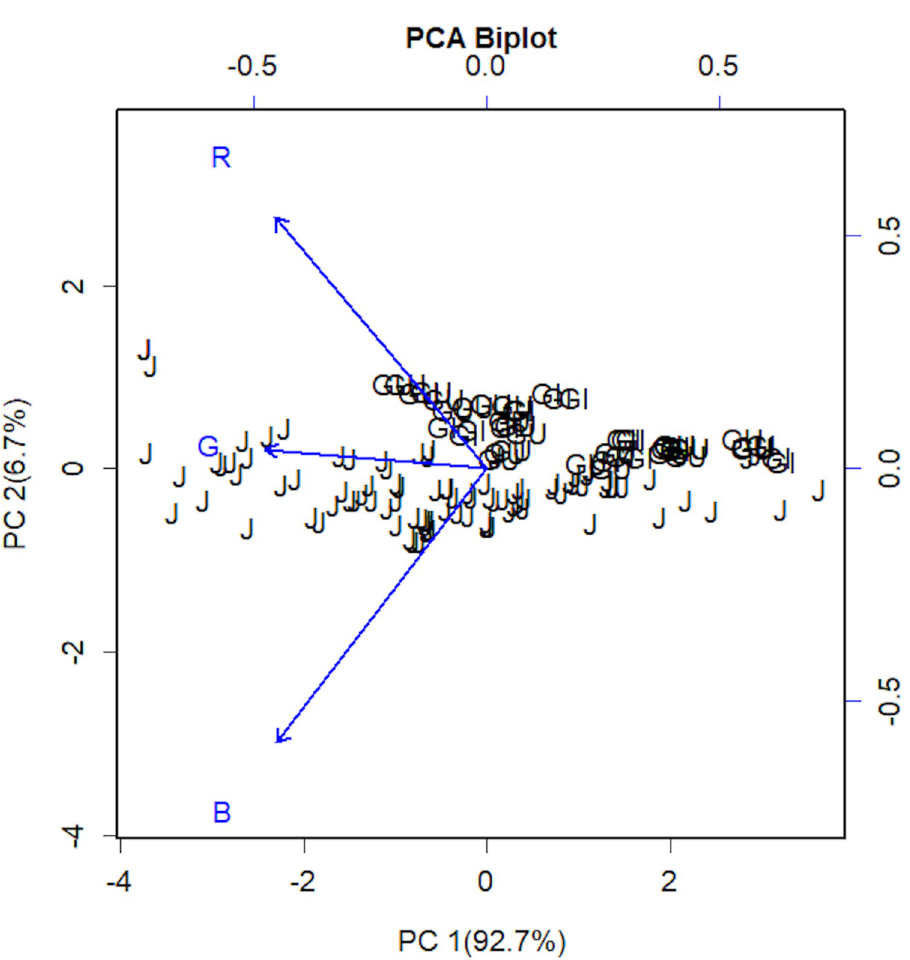
Fig 4. Multivariate data analysis comparing milk treated samples and RGB channels. Principal Component Analysis (PCA) model biplot of variables in Jersey (J), Gir (GI), and Guzerat (GU) milk samples with autoscaling.